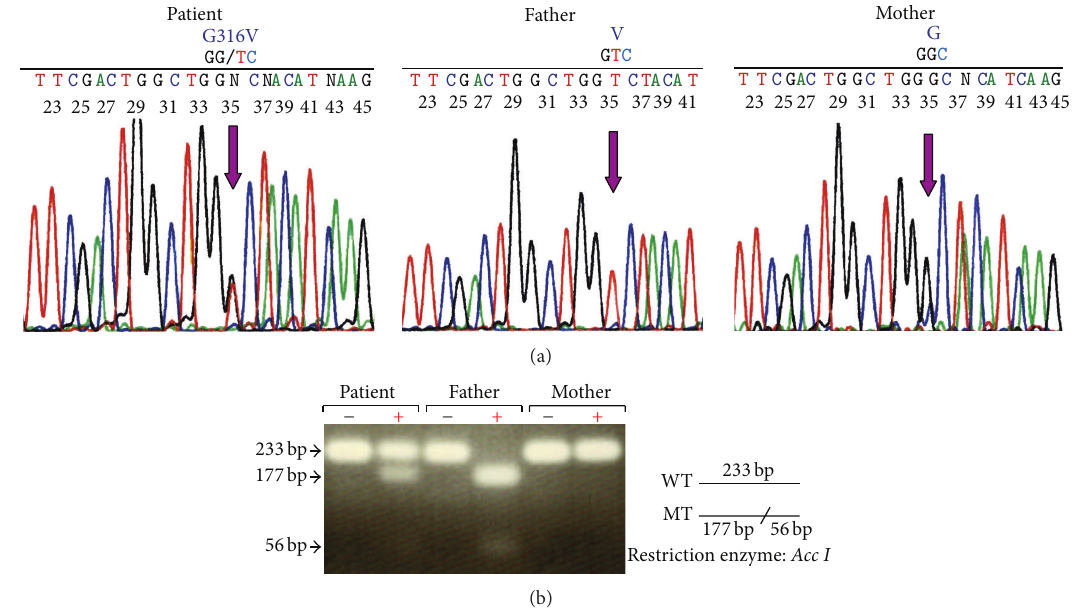
Figure 2: Mutation analyses. (a) PHEX mutation analysis in the patient’s family. A missense mutation in exon 9 (c.947G > T; p.Gly316Val) of the patient was heterozygous. Her father, who exhibited short stature, carried the same mutation. Her mother has no mutation. (b) Restriction enzyme analysis. PCR products of PHEX exon 9 were digested with Acc I and separated on a 4% agarose gel. The wild-type PCR